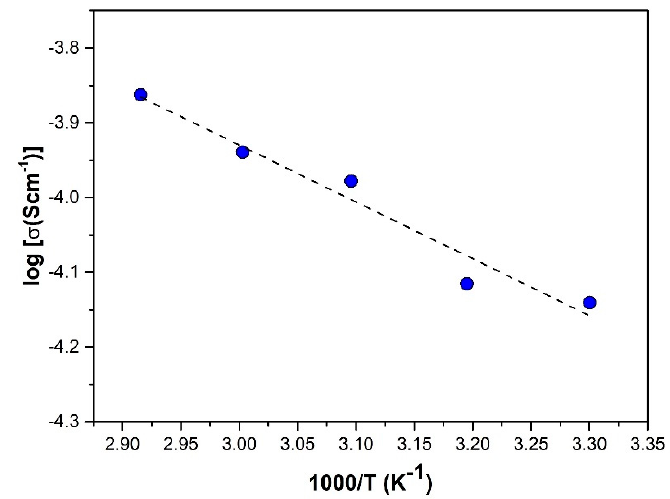
Figure 6. Plot of log conductivity as a function of temperature for SRF60-2.